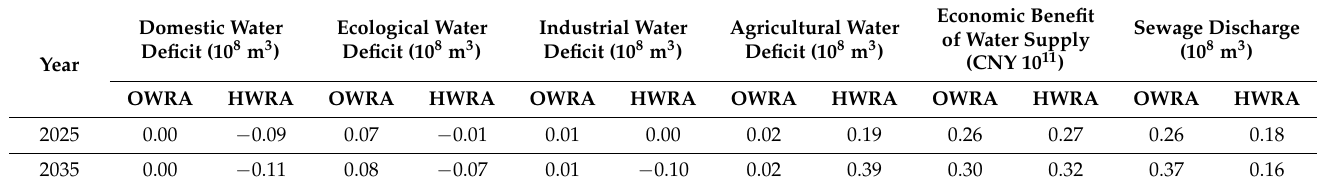
Table 7. Comparison of the results of the OWRA and HWRA models for 2025 and 2035.